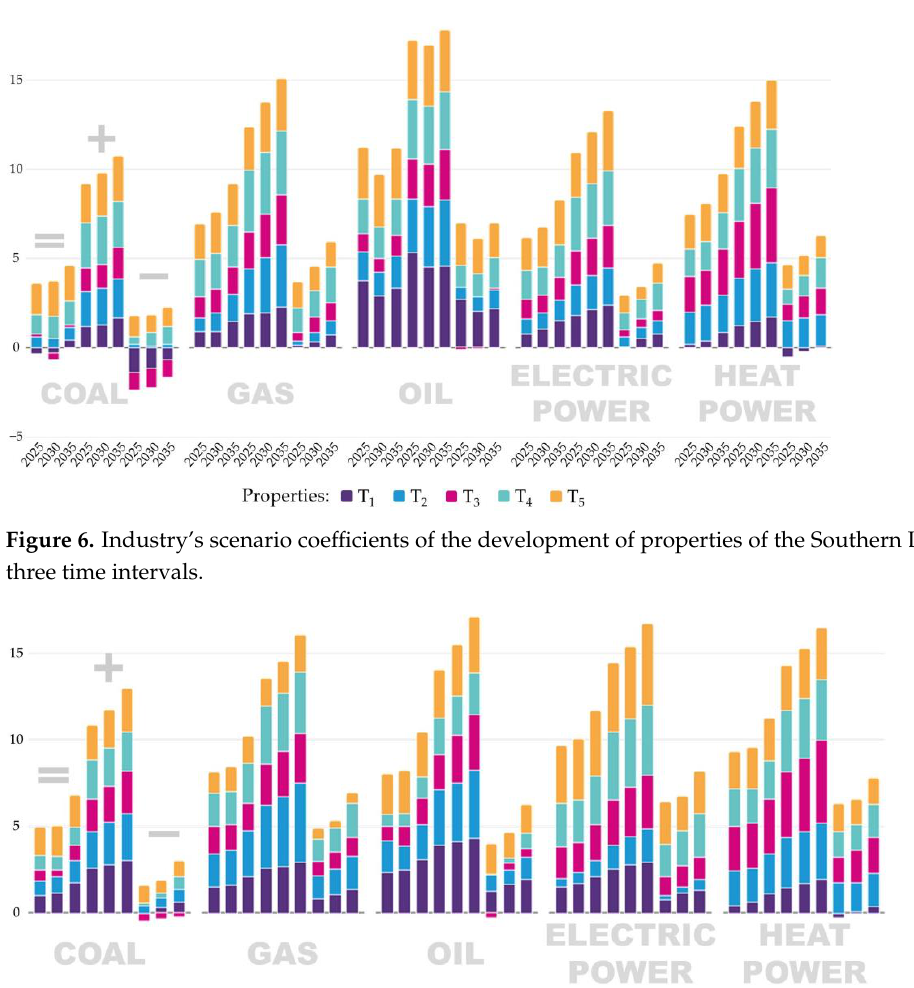
Figure 5. Industry’s scenario coefficients of the development of properties of the Central LFEC at three time intervals.